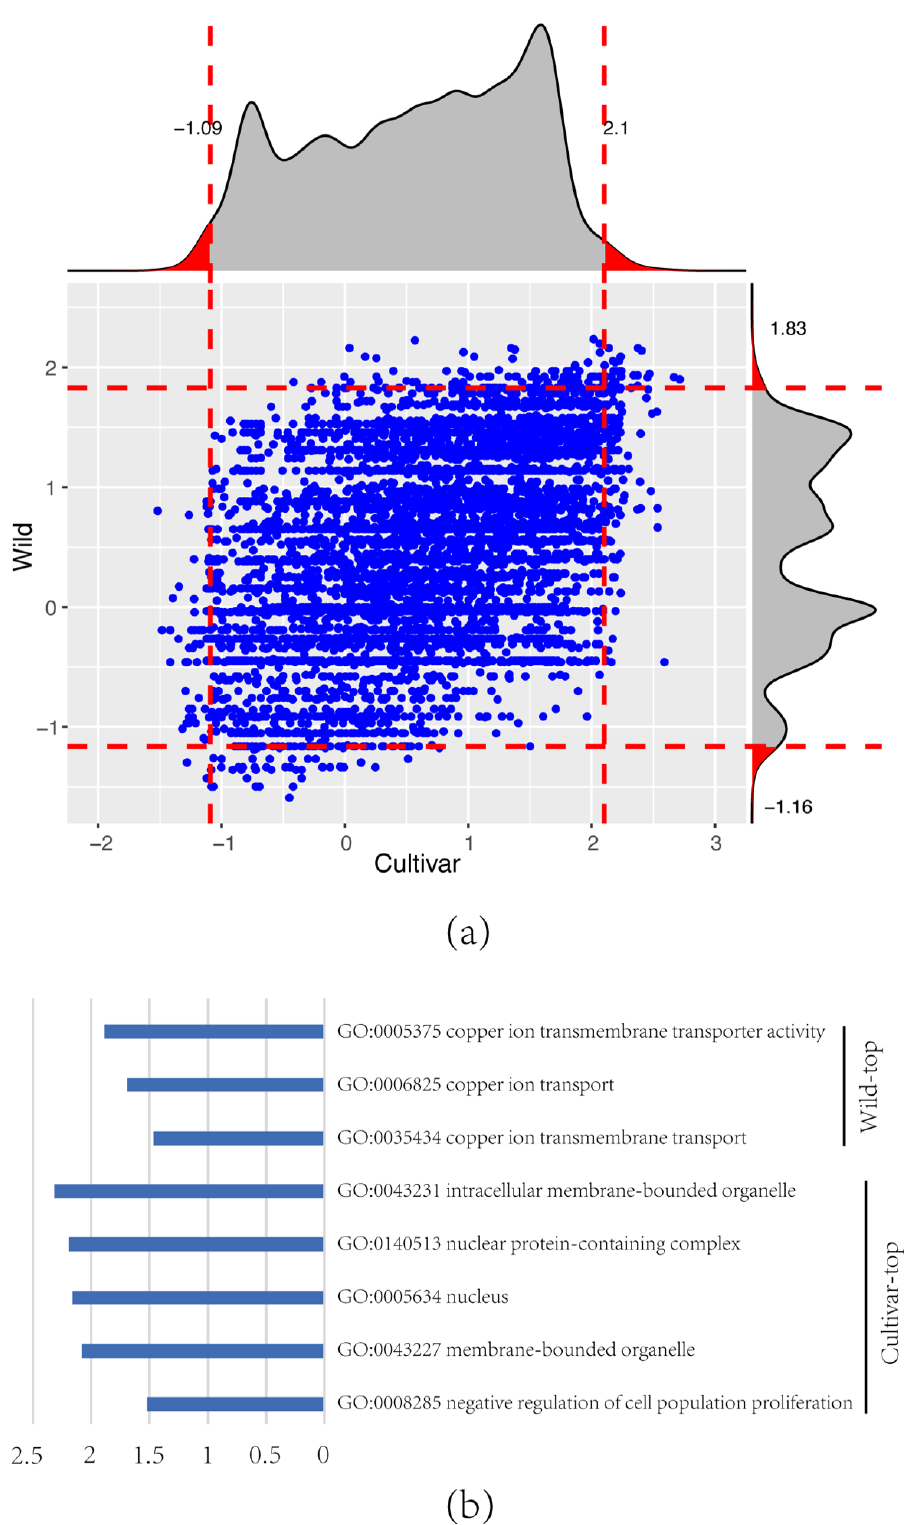
Figure 3. The signature selection in wild and cultivated populations. ( a ) The distribution of the Tajima’s D values. The left and right vertical dashed lines indicate the bottom and top 1% of all values in the cultivars, respectively. The lower and upper horizontal dashed lines indicate the bottom and top 1% of all values in the wilds, respectively. ( b ) The GO enrichment analysis of genes located in the cultivar-top or